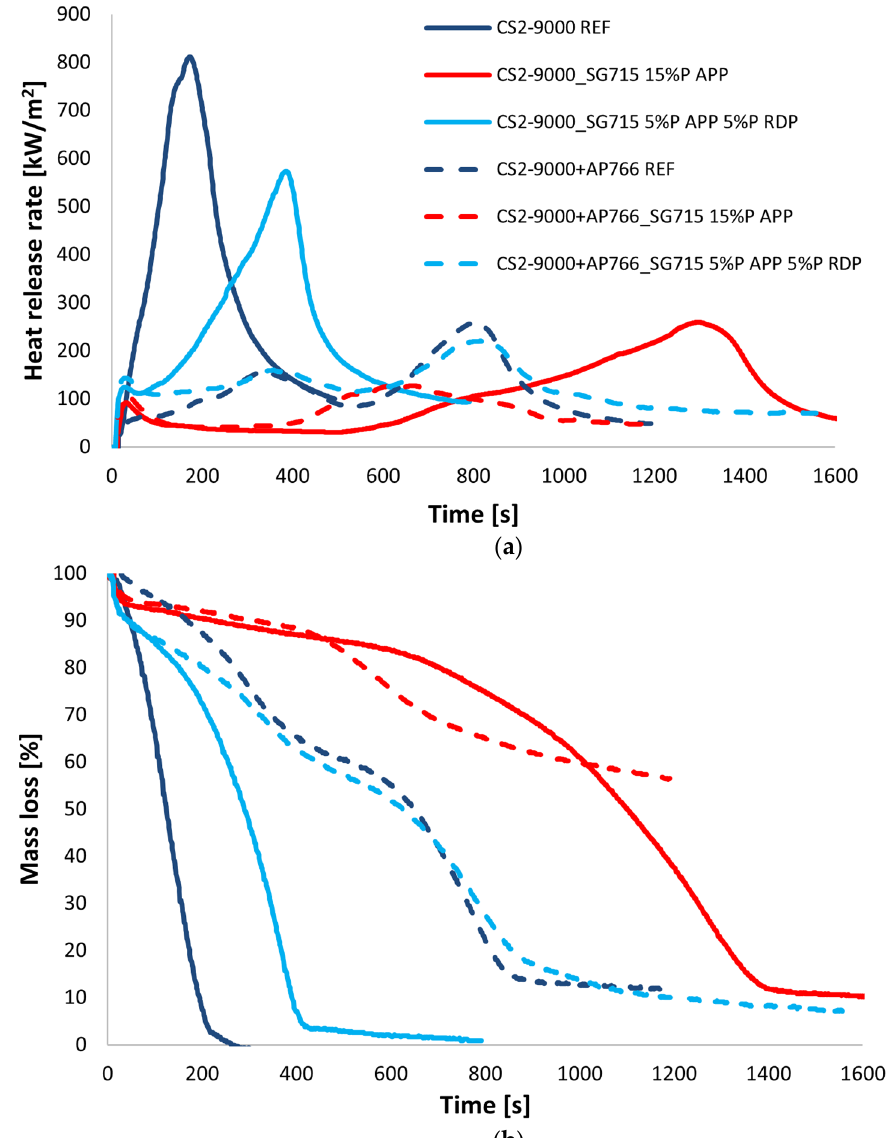
Figure 4. The heat release rate ( a ) and the mass loss ( b ) of CS2-9000-based reference and flame- retarded samples with and without coating.